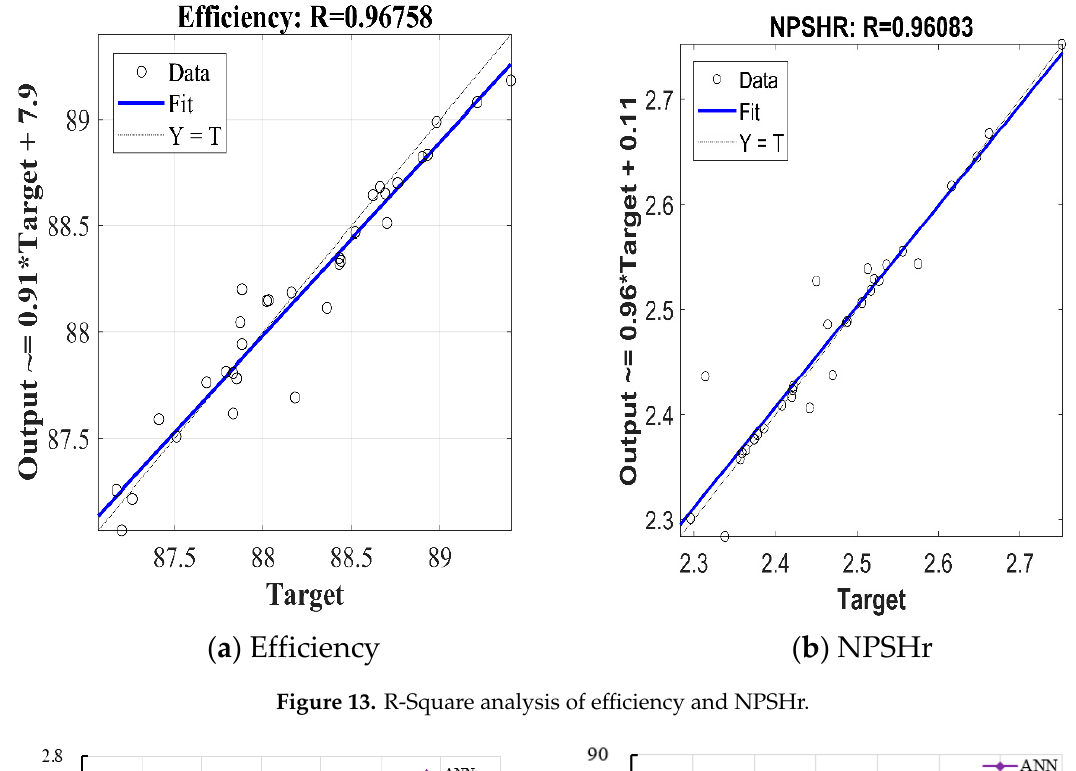
Figure 13. R-Square analysis of efficiency and NPSHr.